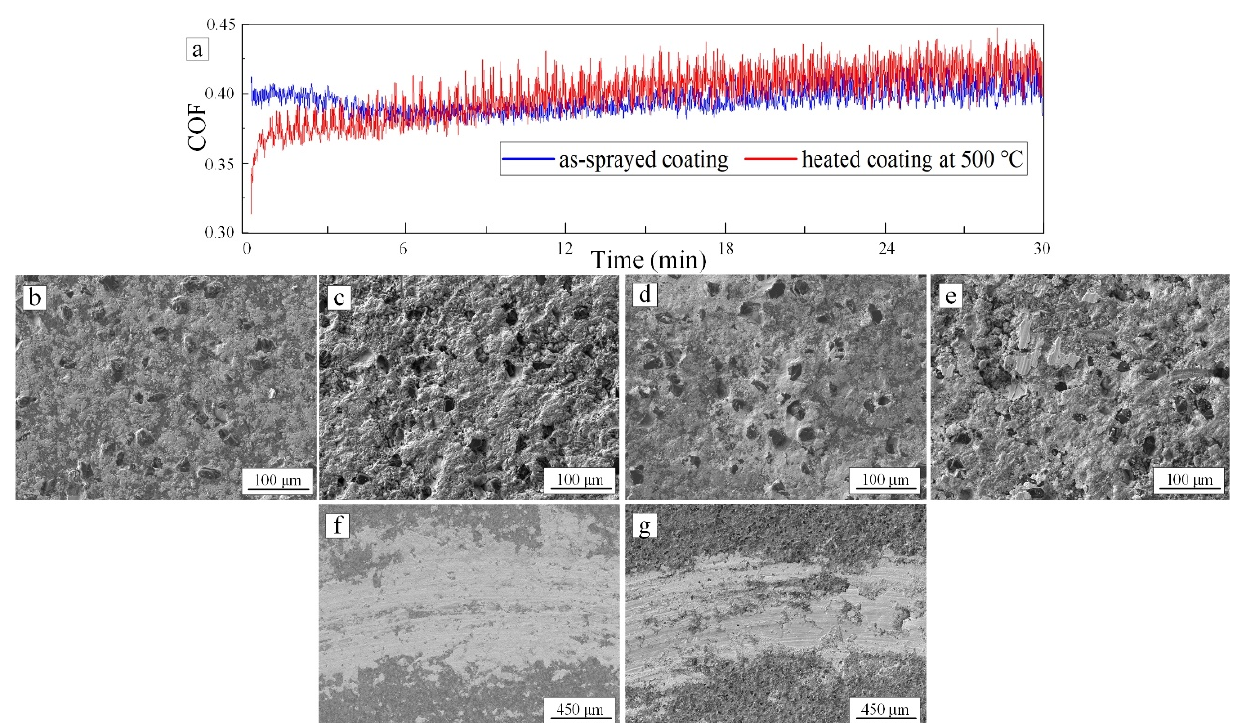
Figure 9. COF versus wear time for as-sprayed coating and 500 °C heat-treated coating ( a ); SEM images of the surfaces of the coatings at different stages ( b – g ); ( b , c ) original surfaces before the tribology test; ( d , e ) surfaces during the tribology test; ( f , g ) final surfaces after the tribology test; ( b , d , f ) corresponding to the as-sprayed coating and ( c , e , g ) corresponding to 500 °C heat-treated coating.